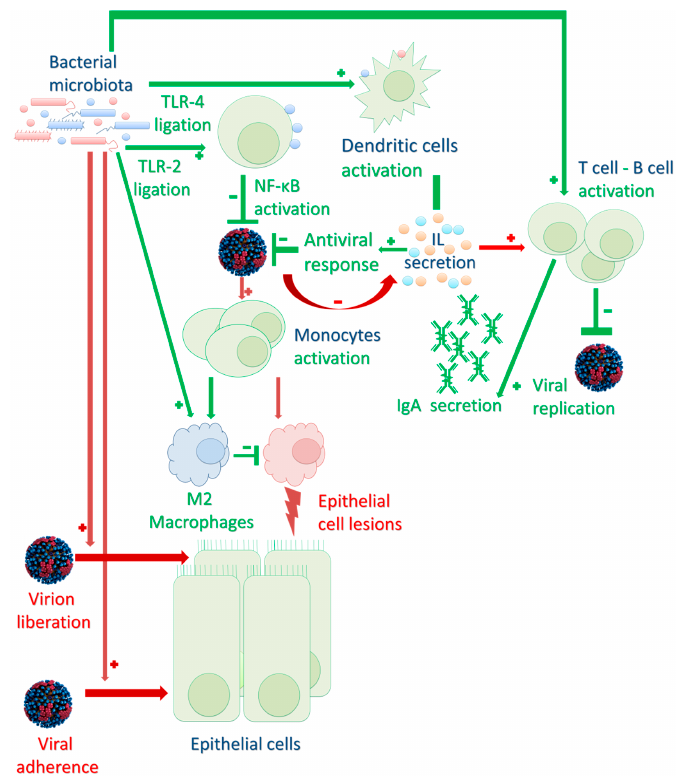
Figure 2. Schematic representations of the host immune system and respiratory microbiome during respiratory viral infections. Red and green arrows and symbol symbolize interactions responsible for severe or mild diseases respectively. Bacterial microbiota could have a direct effect on viral infection (enhancing virion liberation or virion adherence to a new host cell), or an indirect effect on immune response to viral response to infection (activating Toll-like receptors TLR, leading to cellular activation of dendritic cells B/T lymphocytes and monocytes) via interleukin (IL) secretion. Bacterial microbiota has an impact on both innate (inflammation limited by a less-destructive M2 phenotype of macrophages) or adaptive (immunoglobulin A – IgA -, secretion). Viral adhesion enhancement by bacterial microbiota has been well-established in gastro-intestinal infections but need to be studied especially in respiratory infections. Microbiome-associated biomarkers have been suggested to predict respiratory disease severity even before the description of the microbiome concept. For years, it has been observed in patients with cystic fibrosis that detection and an increase in the proportion of some bacterial species, such as